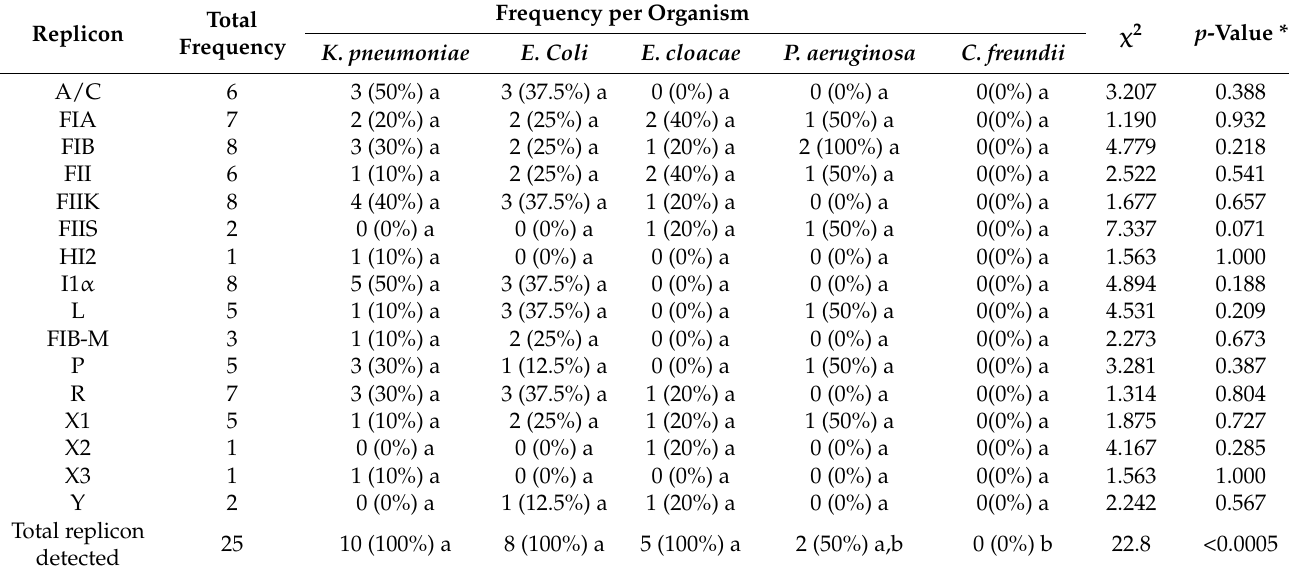
Table 5. Percentage of replicons detected in different organisms. Frequency per Organism